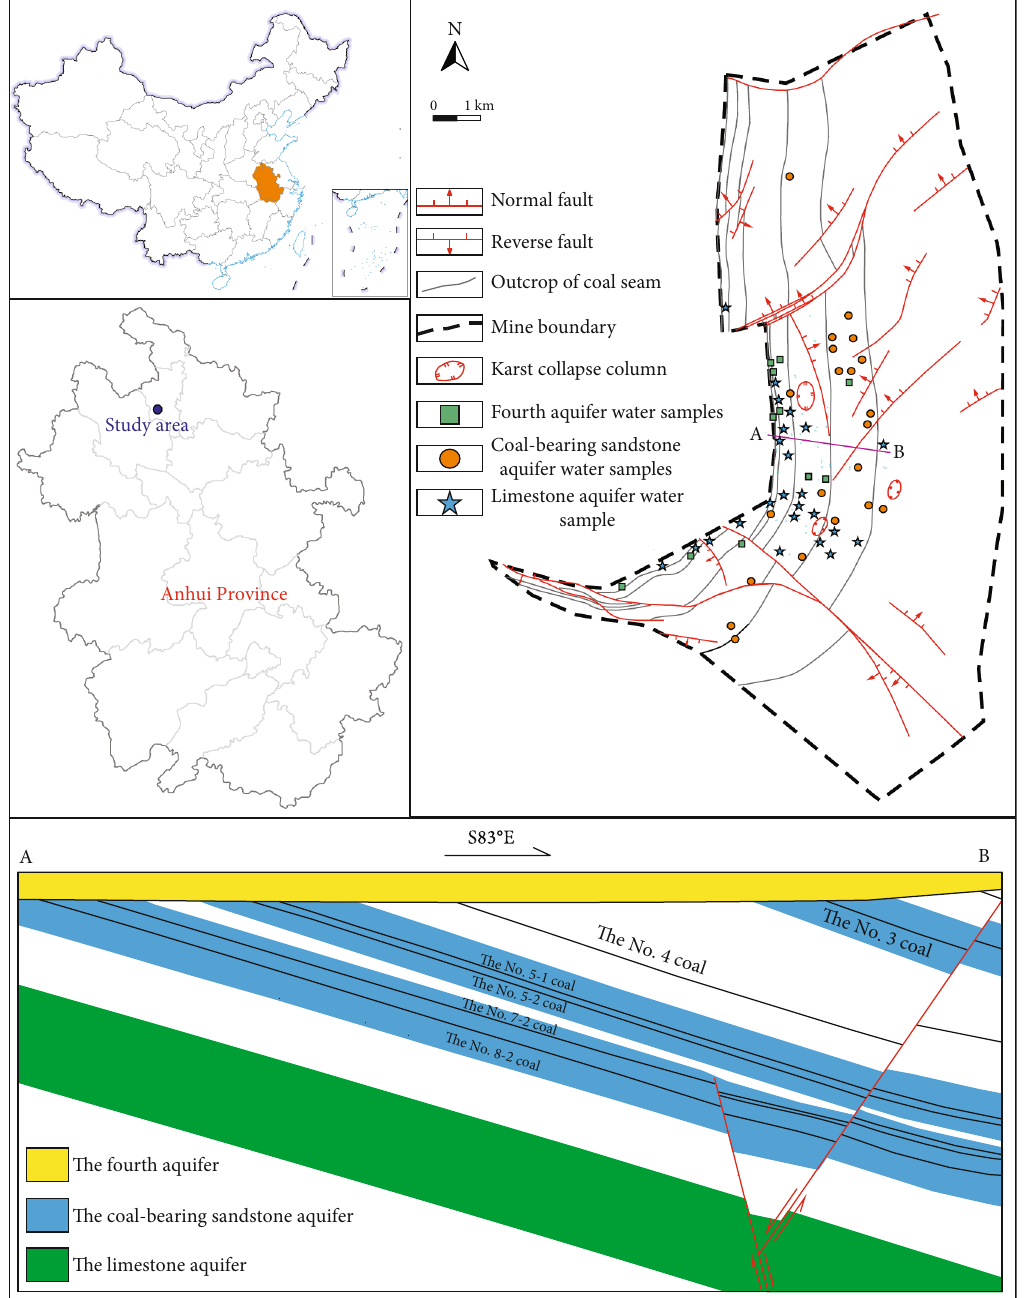
Figure 1: Map showing the location of the study area, with the distribution of faults, folds, sampling sites, and hydrogeologic section within the Renlou Coal